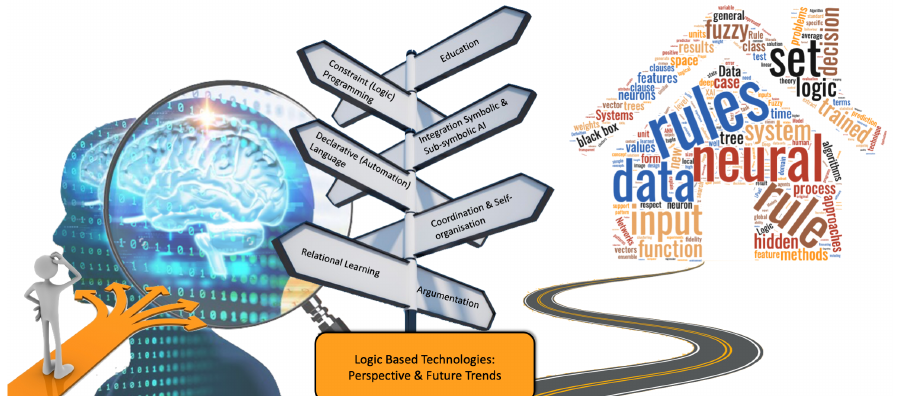
Figure 3. Perspective and future trends for logic-based technologies in symbolic AI. The directional signs illustrate the main research directions currently aiming to answer the AI’s hottest needs, sketched in the CoW (cloud of words) on the right. Words there come from the PDF of the papers discussed in Section 4—Perspectives and Future